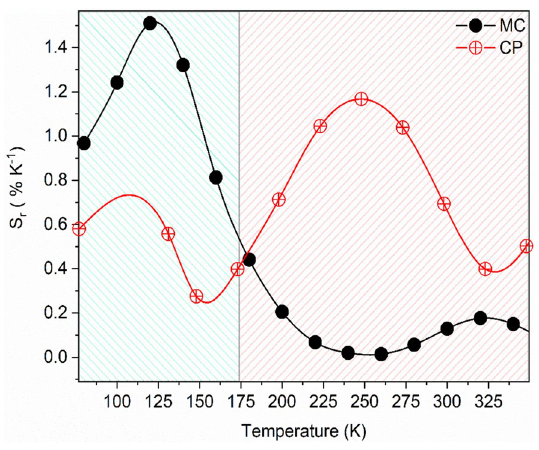
Figure 7. Relative thermal sensitivity values of investigated samples.